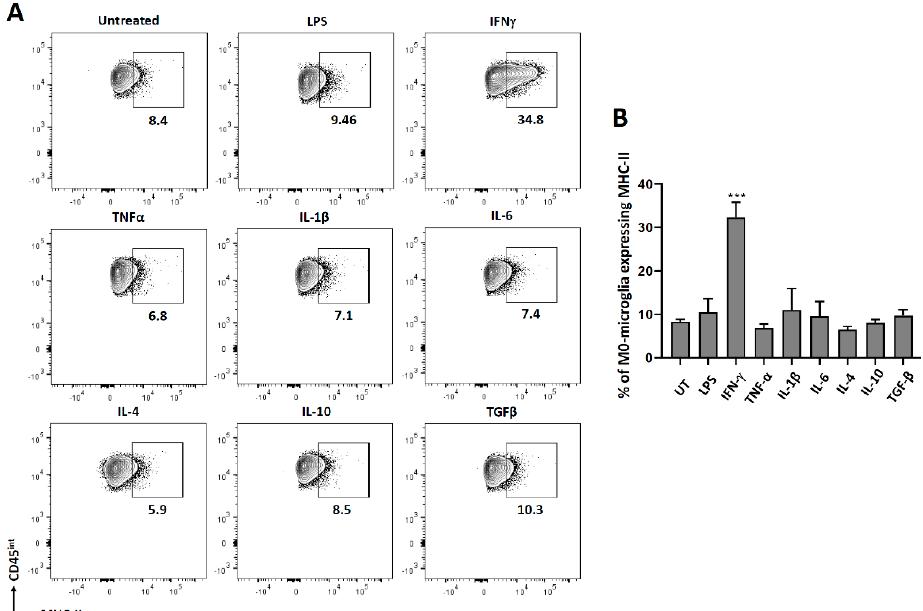
Figure 2. MHC-II expression on non-polarized (M0) microglial cells. Microglial cells were isolated as described. The cells were then treated with several pro- and anti-inflammatory cytokines for 24 h. They were trypsinized and then immuno-stained for MHC-II for flow cytometry. ( A ) Representative contour plots showing microglia (CD45 int ) expressing MHC-II. ( B ) Graphical representation of MHC-II expression after 24 h of treatment. UT-untreated control. Experiments were carried out three times with duplicate wells. *** p < 0.001.